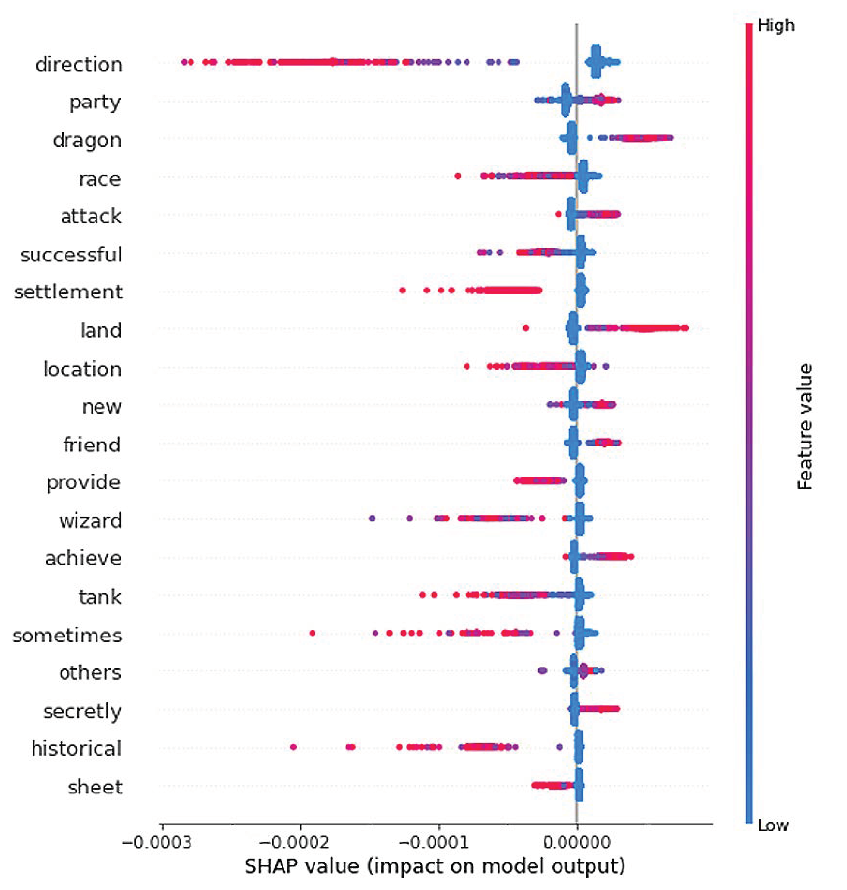
Figure 6. An example of interpretable machine learning result in the context of the Game Analytics Scenario scenario: summary plot for classification of games, Fantasy